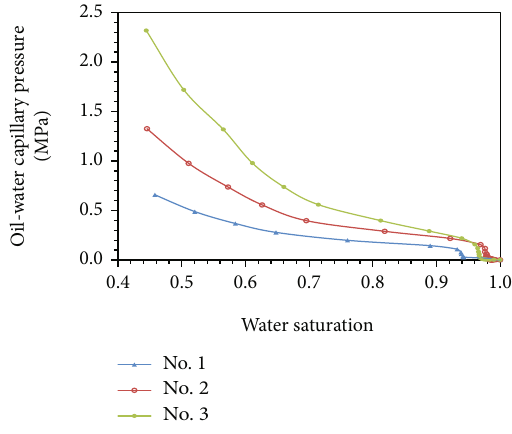
Figure 3: Curves of oil-water capillary